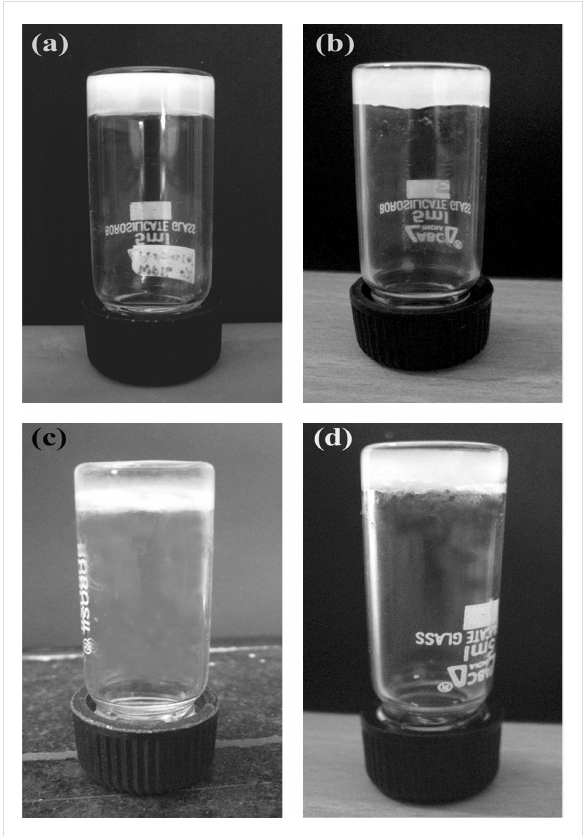
Figure 1: Organogels formed by TPM-G12 in (a) propan-1-ol; (b) DMSO at 0.5% w/v; (c) organogel from TPM-G5 in DMSO at 2% w/v; (d) organogel from TPM-G4 in diethylene glycol at 4% w/v.